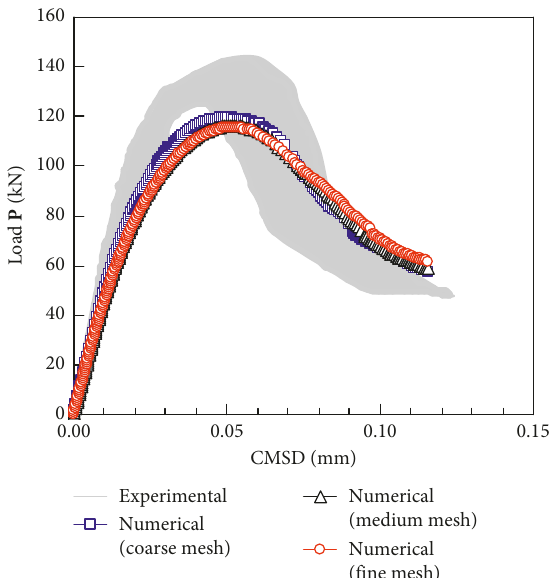
Figure 16: Load-CMSD curves for SEN concrete beam obtained with different FE mesh